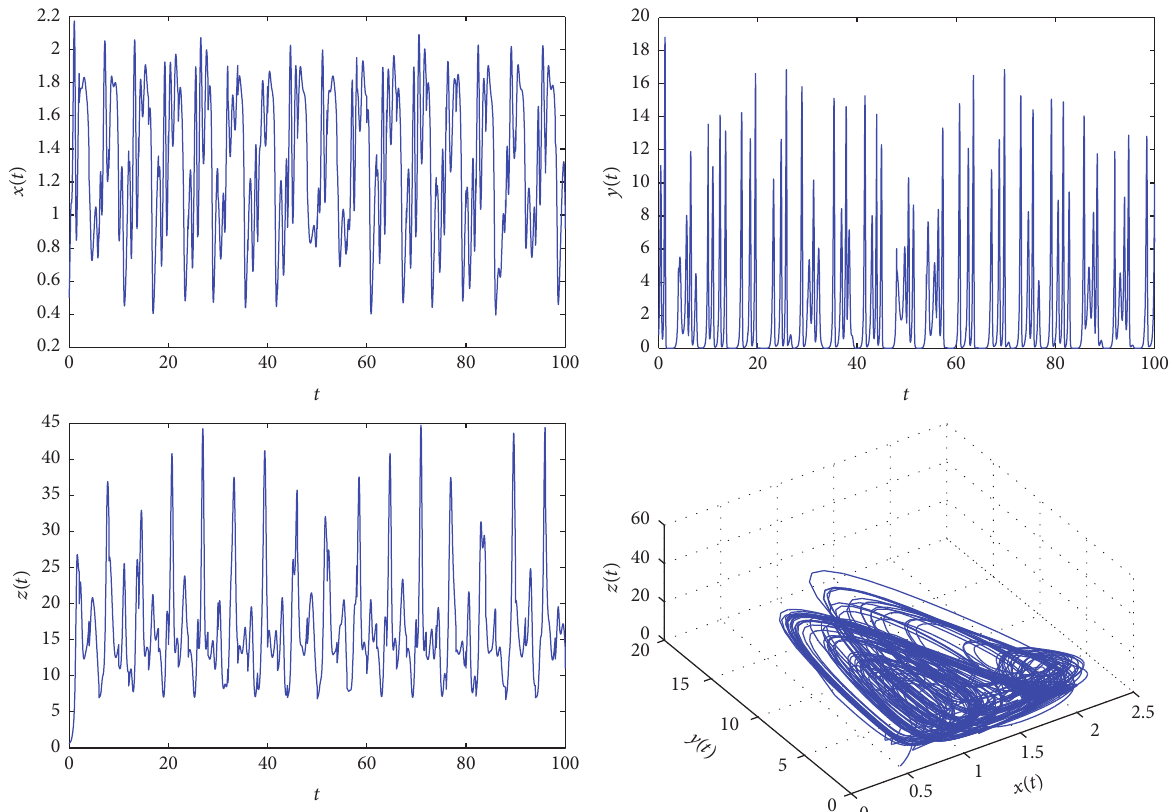
Figure 5: Effect of delays on the dynamical behavior of system (1) with 𝜙 1 (𝑠) = 𝑥(0) = 0.5 , 𝜙 2 (𝑠) = 𝑦(0) = 0.8 , 𝜙 3 (𝑠) = 𝑧(0) = 0.6 , 𝑠 ∈